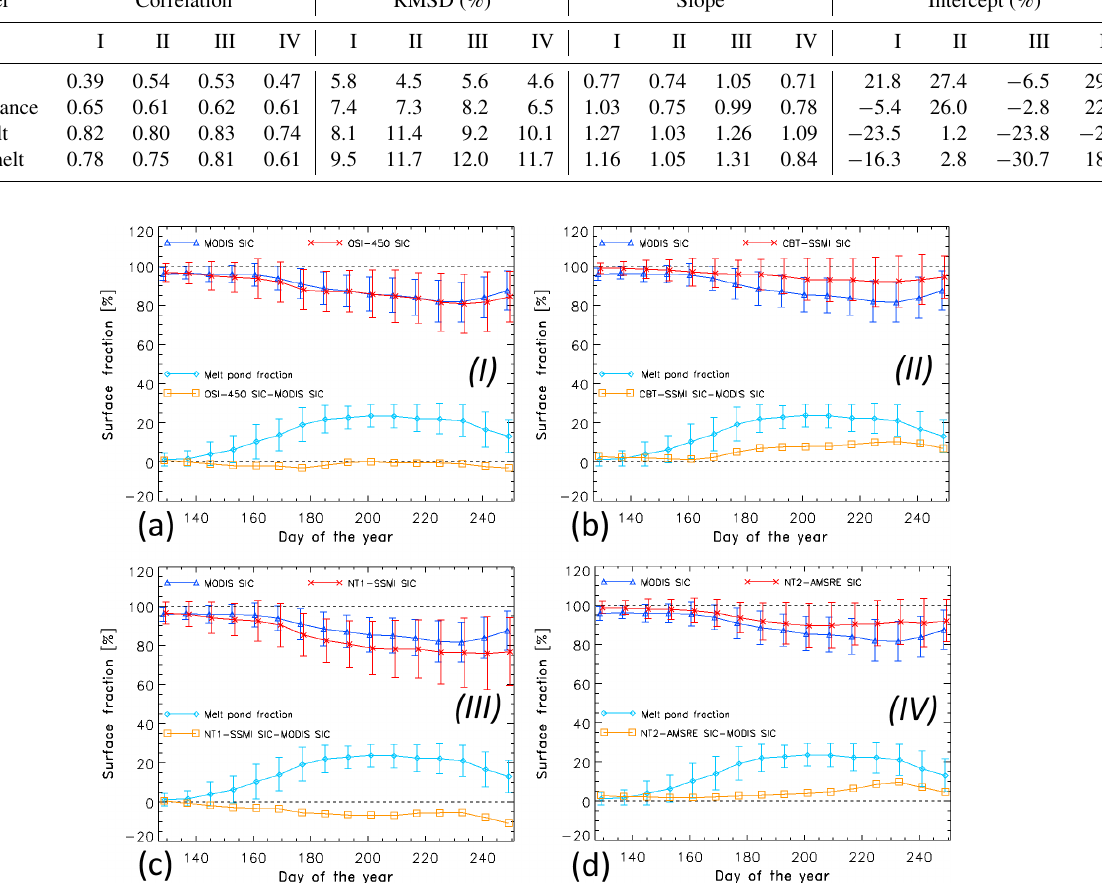
Figure 6. Average seasonal cycle of the mean (limited to Arctic Ocean and Canadian Arctic Archipelago) MODIS SIC (in blue), PMW SIC (in red), their difference of PMW minus MODIS SIC (in orange), and the MODIS melt pond fraction (in cyan), averaged for each 8d period for the years 2003–2011 of the PMW products representing groups I to IV (see also Fig. S7, Supplement). Error bars denote 1 standard deviation of the mean. Roman numbers in bold font denote the group (see Table 1) to which the algorithm is